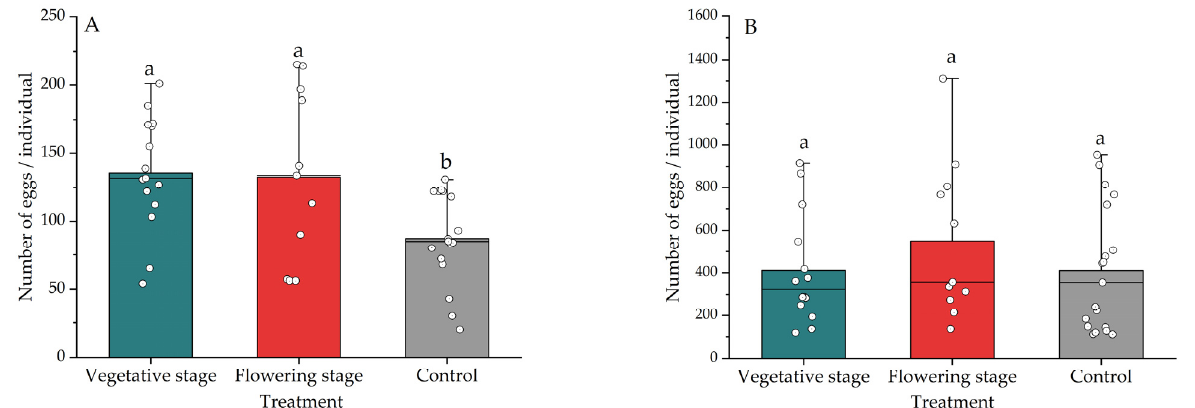
Figure 2. Effect of the Ocimum basilicum phenological stage on Chrysopa pallens fecundity. ( A ) shows the C. pallens egg deposition rates during the first 5 days, while ( B ) indicates the total (lifetime) egg deposition per female. Different letters indicate significant differences between treatments (ANOVA, Fisher’s LSD test for mean separation, p <